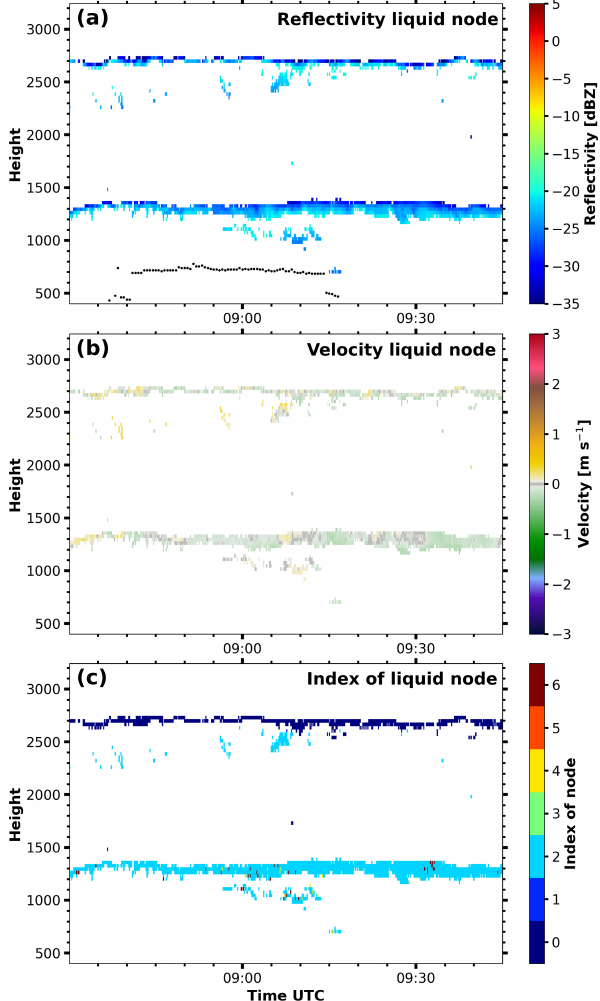
Figure 7. MIRA-35 reflectivity with lidar-detected cloud-base height (black dots, a ), mean velocity (b) and index of node (c) for nodes identified as liquid cloud drops by the selection rule from Sect. 3.2.1 on 29 June 2017 from 08:30 to